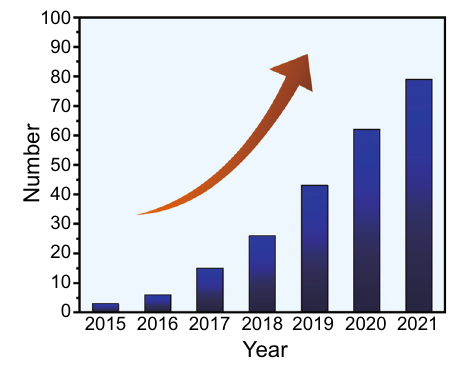
Fig. 2 Number of published papers of MOF-based MAMs from 2015 to 2021(Web of science)